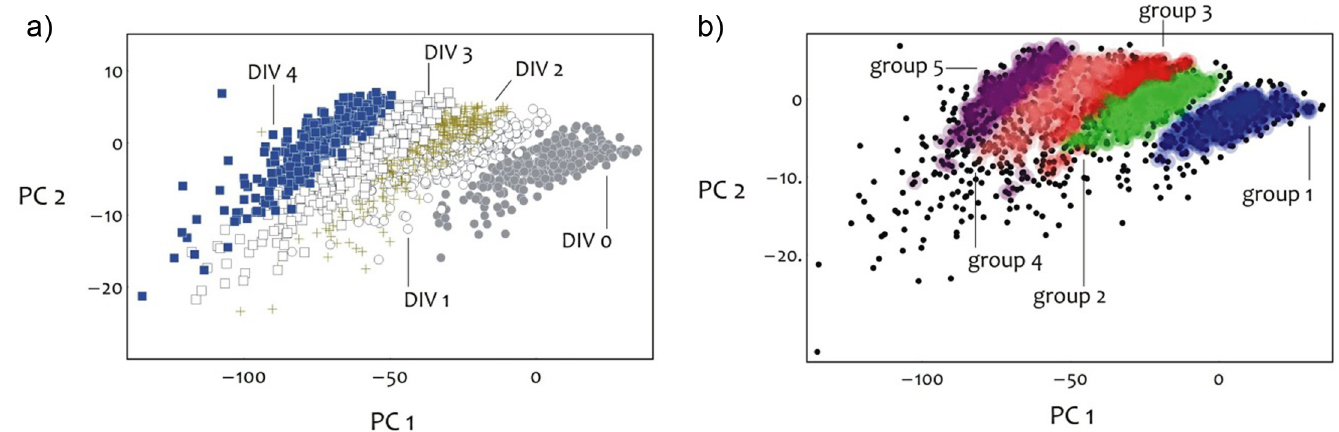
Fig 4. PCA of the Raman spectra from DIV0 to DIV4. PCA of the collectedRaman spectra groupedper day (a) and groupedper similarities (b) accordingto the algorithmdeveloped in [44]. For each DIV, the Raman spectra acquiredin all the four replicatesare considered.